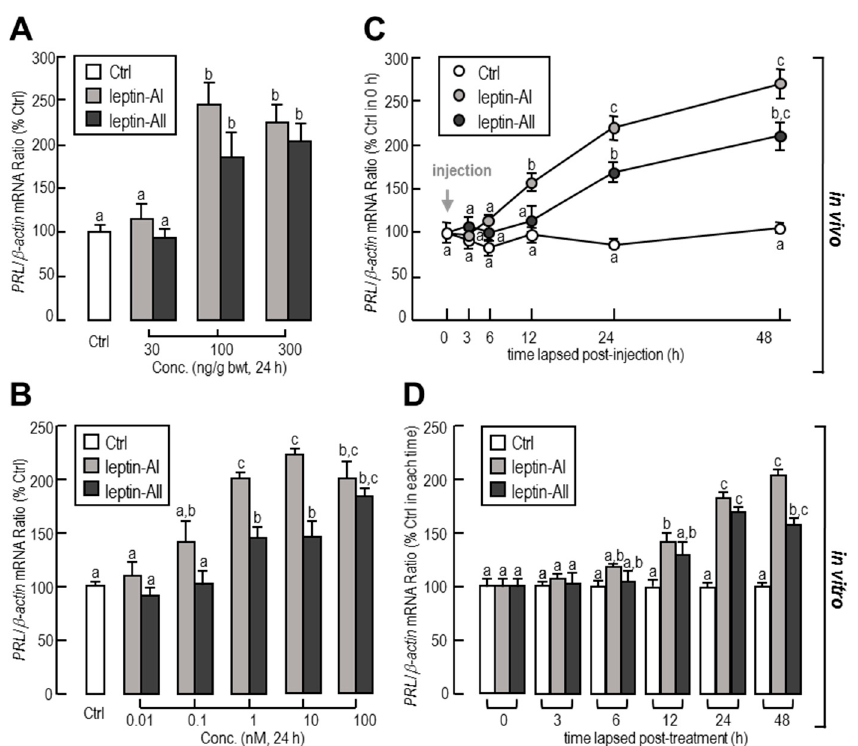
Figure 1 . In vivo and in vitro effects of leptin-AI and leptin-AII treatment on PRL transcripts in goldfish. Dose- ( A ) and time-dependent ( B ) effects of leptin-AI or leptin-AII IP injection on PRL mRNA expression in the pituitary. For time-course experiments, goldfish were IP injected with leptin-AI or leptin-AII at 100 ng/g for 0, 3, 6, 12, 24 and 48 h. For dose-dependence experiments, the goldfish were IP-injected with leptin-AI or leptin-AII for 24 h with increasing doses (1 − 100 ng/g). Dose- ( C ) and time-dependent ( D ) effects of leptin-AI or leptin-AII incubation on PRL mRNA expression in primary cultured pituitary cells. For time-course experiments, goldfish pituitary cells were incubated for 3, 6, 12, 24, and 48 h with leptin-AI or leptin-AII, at a concentration of 100 nM. For dose-dependence experiments, goldfish pituitary cells were incubated with leptin-AI or leptin-AII for 24 h with increasing doses (0.01 − 100 nM). In these studies, data are expressed as the mean ± standard error (SE, n = 10 for the in vivo study, and n = 4 for the in vitro study). The same letter represents a similar level of transcriptional expression ( p > 0.05), and a different letter represents significant difference in levels of transcriptional expression between two groups ( p < 0.05).